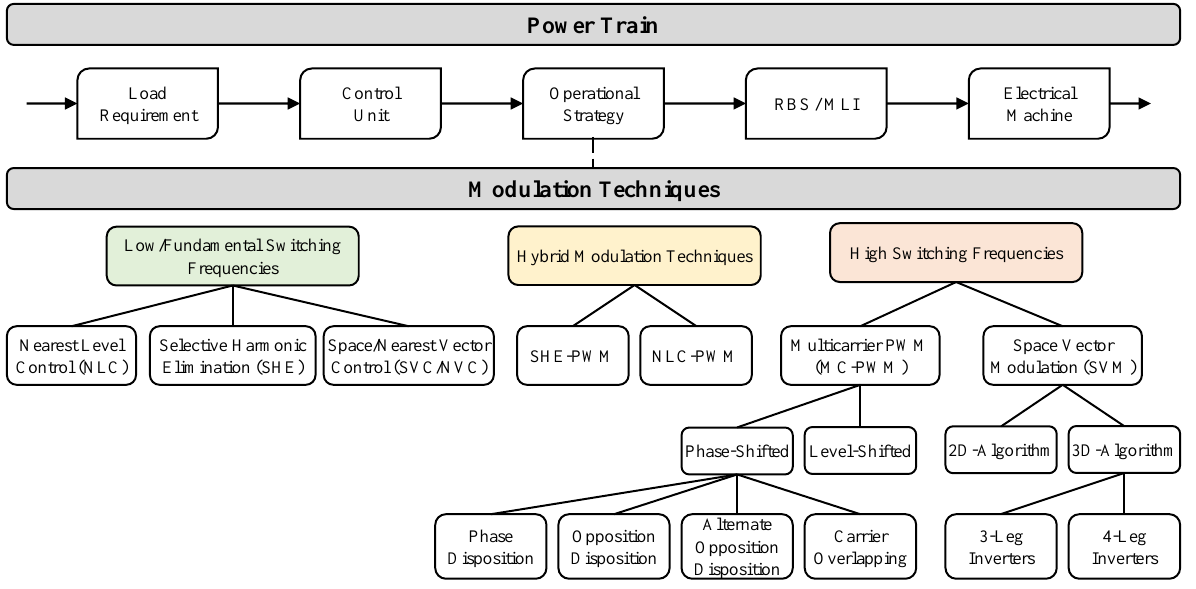
Figure 8. Schematic flow chart of the power train and cluster of modulation